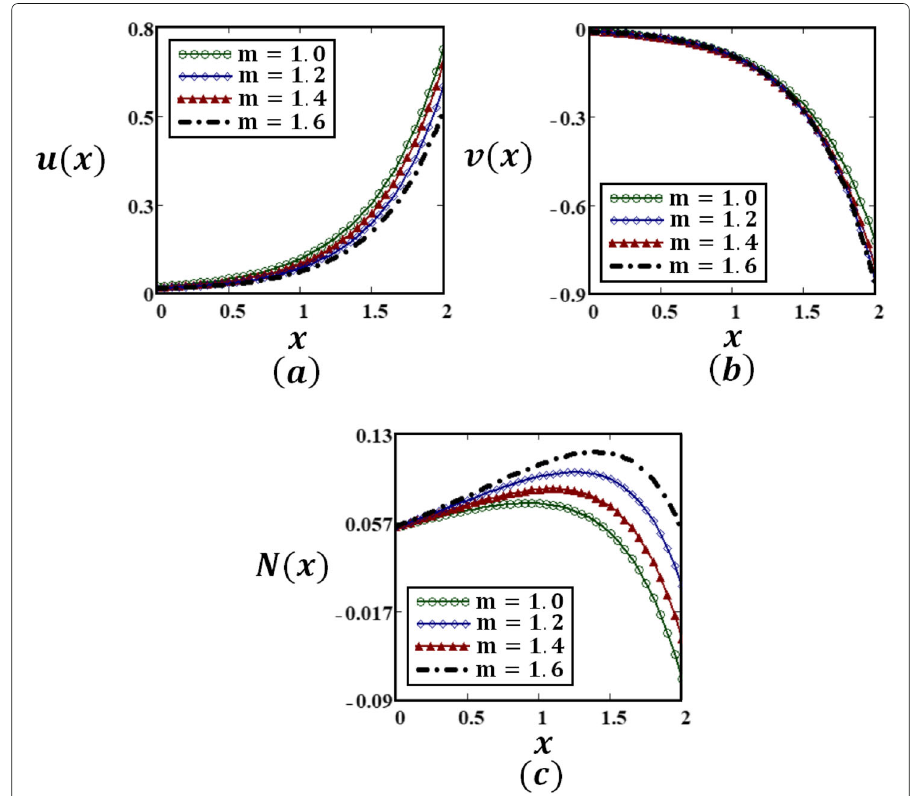
Fig. 9 Profiles of the velocity field u ( x , t ) , v ( x , t ) , and microrotation N ( x , t ) for MHD micropolar fluid given by Eqs. (32), (33), and (34), for U = 0.1, ν = 0.045, μ = 0.5, κ = 0.2, B 0 = 2, k ∗ = 0.2, σ = 0.2, j = 0.03, n = 1, y = 1, c 0 = 0.01, t = 2 s , and different values of